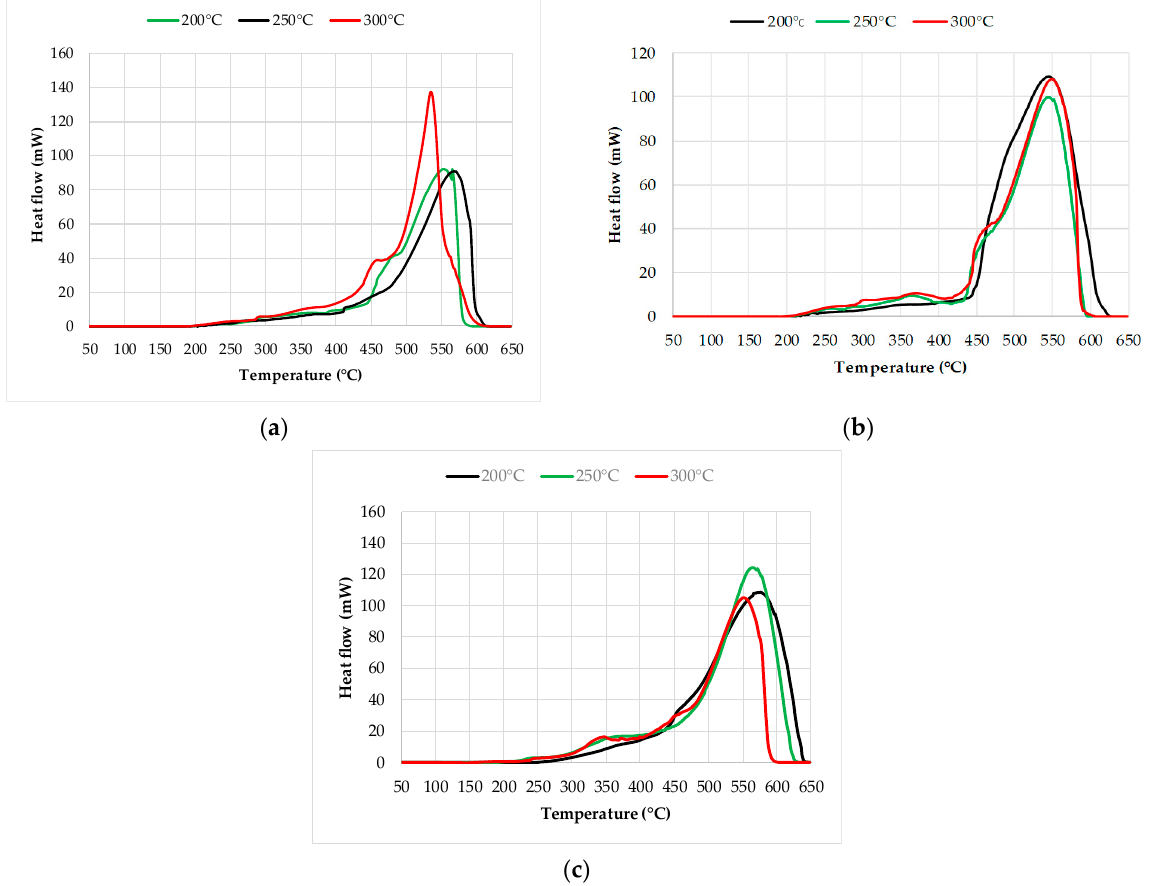
Figure 10. DSC curves of tar fractions that were obtained by MW-assisted torrefaction of biomass at different temperature: ( a ) softwood, ( b ) wheat straw, and ( c ) peat. Table 3. Heat output (Q) and the calculated efficiency (Eff.) coefficients according to the DSC tests in air media of the solid and tar fractions that were obtained by MW-assisted torrefaction of biomass at different temperatures.